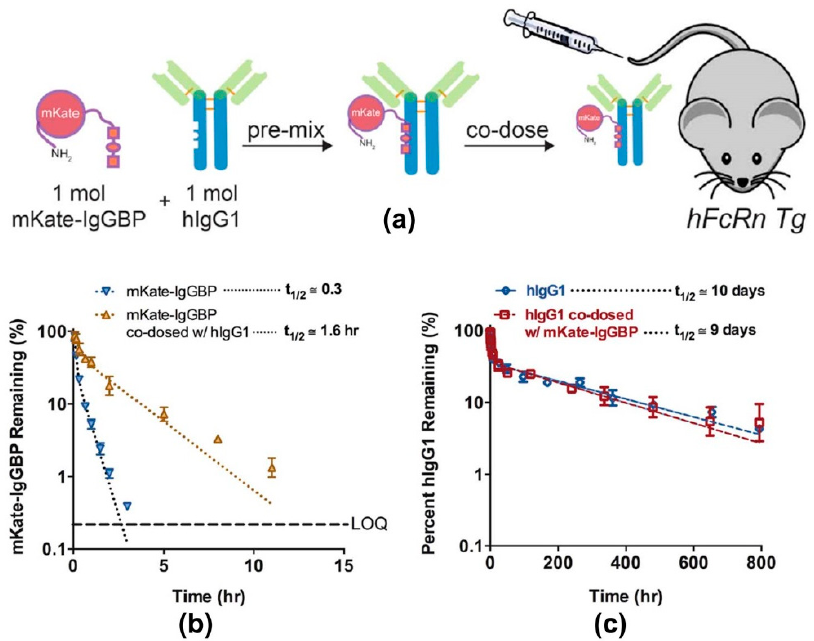
Figure 9. ( a ) Schematic of the co-administration scheme. In this experiment, human FcRn Tg mice were not pre-dosed with exogenous hIgG1. Instead mKate-IgGBP and hIgG1 were pre-mixed in a 1:1 molar ratio and co-injected via the tail vein; ( b ) clearance of mKate-IgGBP in hFcRn Tg mice dosed alone (blue triangles) or co-dosed at a 1:1 molar mixture with hIgG1 (yellow triangles). The mKate-IgGBP remaining (%) was calculated by normalizing the fluorescent emission at all time points to the maximum value observed in the first bleed 5 min after protein injection; ( c ) clearance of labeled human IgG1 in hFcRn Tg mice dosed as a single agent via the tail vein (blue triangles) compared to the clearance of labeled hIgG1 co-administered as a 1:1 molar mixture with mKate-IgGBP was measured to determine if bound mKate-IgGBP alters the eliminate profile of hIgG1 (red squares). The hIgG1 remaining (%) was calculated by normalizing the fluorescent emission at all time points to the maximum value observed in the first bleed 5 min after protein injection. Dashed lines in each panel represent the data fit to a 2-compartment PK model in Prism and the β -phase half-life shown in the figure was calculated as described in the Methods section. The data shown in each panel are the mean ( n = 3 bleeds per time point) and error bars indicate standard deviation. Adapted from [74].